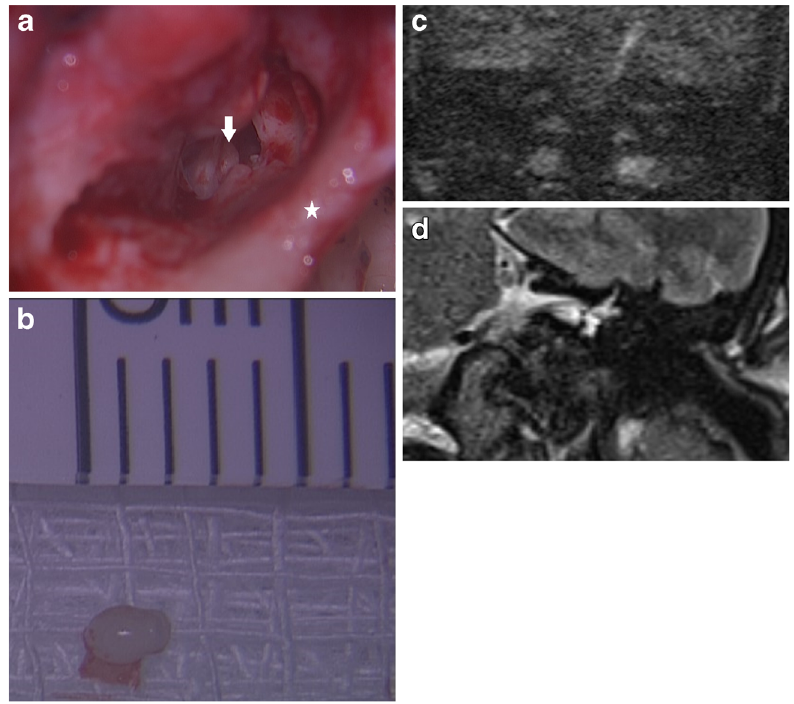
Fig. 5 False negative case for cholesteatoma on DWI. a , b A small 2 mm cholesteatoma pearl ( white arrow ) was found on surgery in the hypotympanum (star denotes posterior canal wall) , but was not depicted on c the corresponding 2 mm thick coronal b1000 image or d T2 weighted